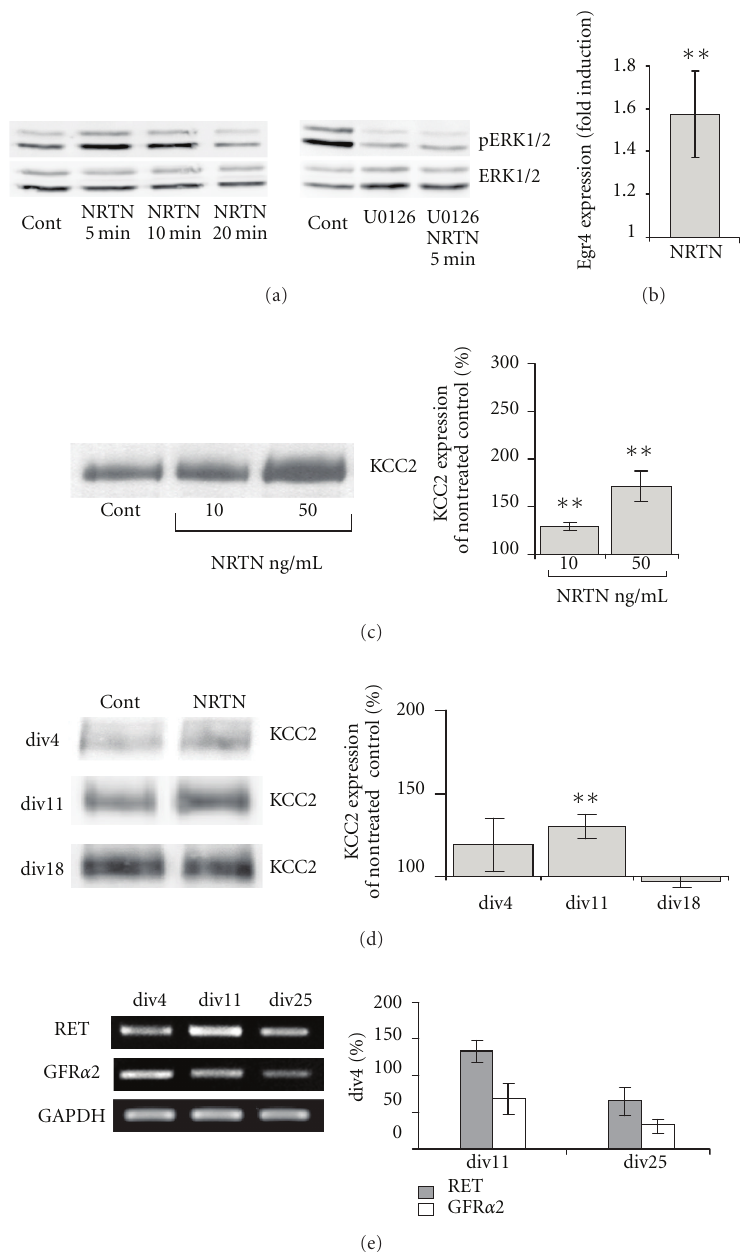
Figure 1: Regulation of KCC2 expression by Neurturin. (a) Representative Western blot analysis of Neurturin-induced ERK1/2 phosphorylation. Lysates of div5-dissociated cultures were collected 5–20 min after Neurturin (50ng/mL) application. In some cases